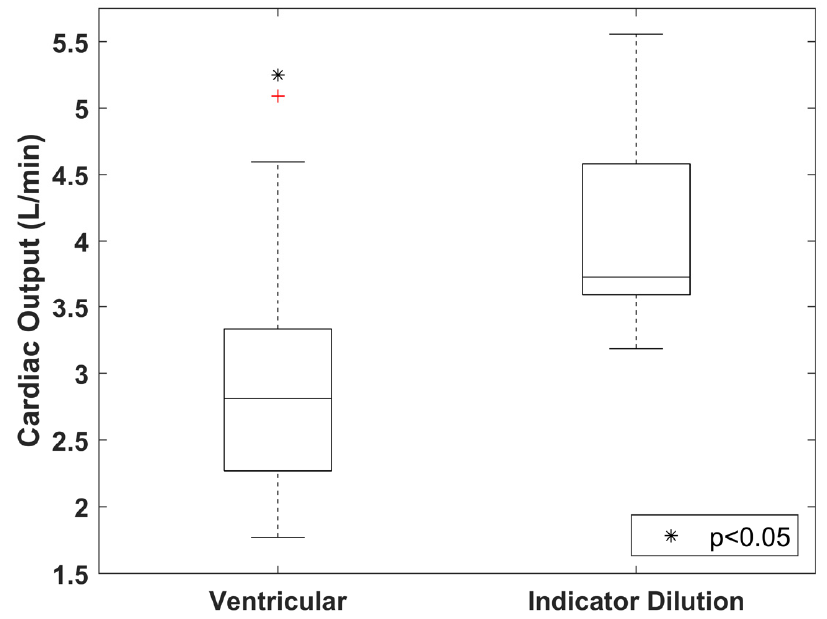
Figure 6. Comparison in the CO indexes assessed with the ventricular delineation and indicator dilution methods in 17 CT myocardial perfusion studies. The cross in the boxplot represents outliers; * denotes p < 0.05 with respect to the indicator dilution